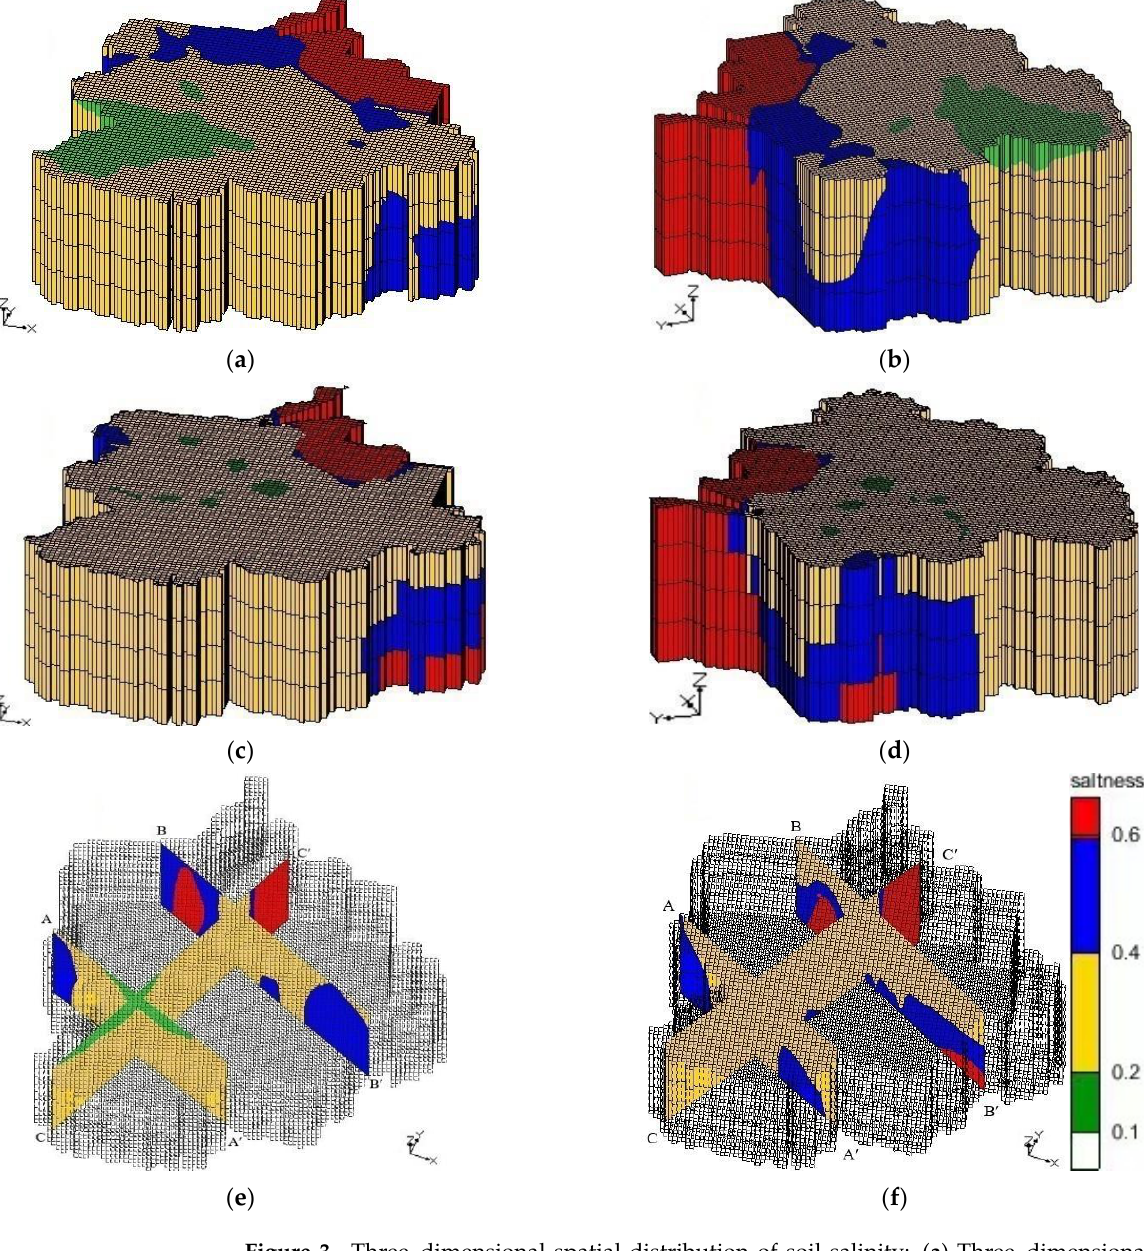
Figure 3. Three – dimensional spatial distribution of soil salinity: ( a ) Three – dimensional spatial dis- Figure 3. Three–dimensional spatial distribution of soil salinity: ( a ) Three–dimensional spatial tribution map of soil salinity in spring; ( b ) Three – dimensional spatial distribution map of soil salin- distribution map of soil salinity in spring; ( b ) Three–dimensional spatial distribution map of soil ity after 90° counterclockwise rotation of ( a ); ( c ) Three – dimensional spatial distribution map of soil salinity after 90 ◦ counterclockwise rotation of ( a ); ( c ) Three–dimensional spatial distribution map salinity in summer; ( d ) Three – dimensional spatial distribution map of soil salinity after 90° coun- of soil salinity in summer; ( d ) Three–dimensional spatial distribution map of soil salinity after terclockwise rotation of ( c ); ( e ) Typical profile of three – dimensional soil salinity in spring; ( f ) Typical 90 ◦ counterclockwise rotation of ( c ); ( e ) Typical profile of three–dimensional soil salinity in spring; profile of three – dimensional soil salinity in summer. ( f ) Typical profile of three–dimensional soil salinity in